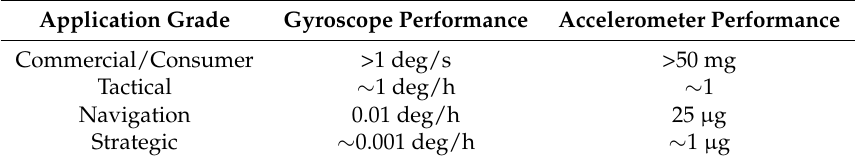
Table 1. Classification of the inertial sensors due to the application areas